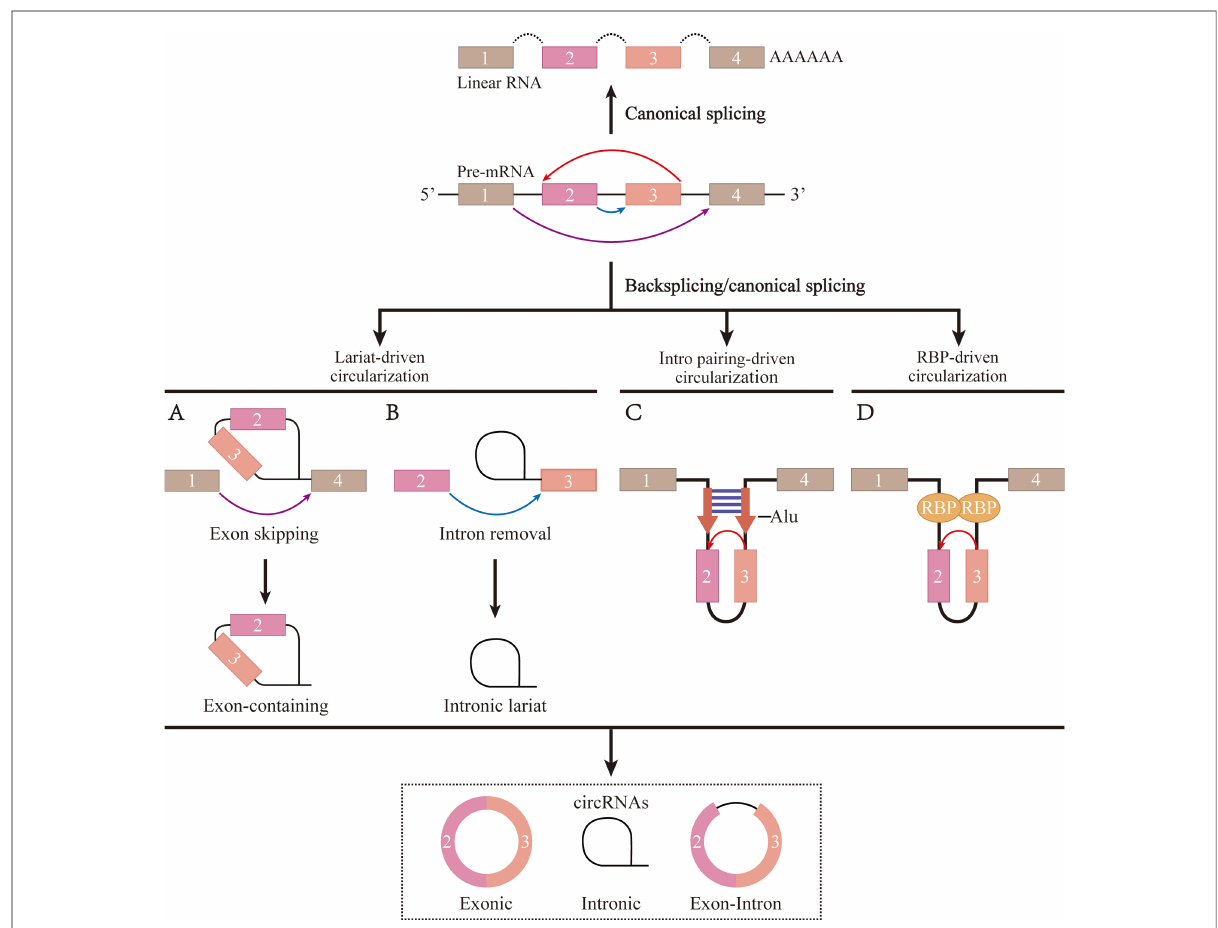
FIGURE 1 The formation process of circRNA. ( A ) The ribosomal protein assembles at the 5 ’ and 3 ’ splice site of the cyclized exon to form a lariat structure, causing exon skipping and driving circularization. ( B ) To form a mature circRNA, the intron relies on reverse splicing of the motif sequences at the 5 ’ and 3 ’ ends to drive circularization, followed by shearing. ( C ) The fl anking introns of the cyclized exon forme parallel side-by-side duplexes through base-complementary pairing to drive circularization. ( D ) RNA-binding protein promotes exons circularization by binding to fl anking intron